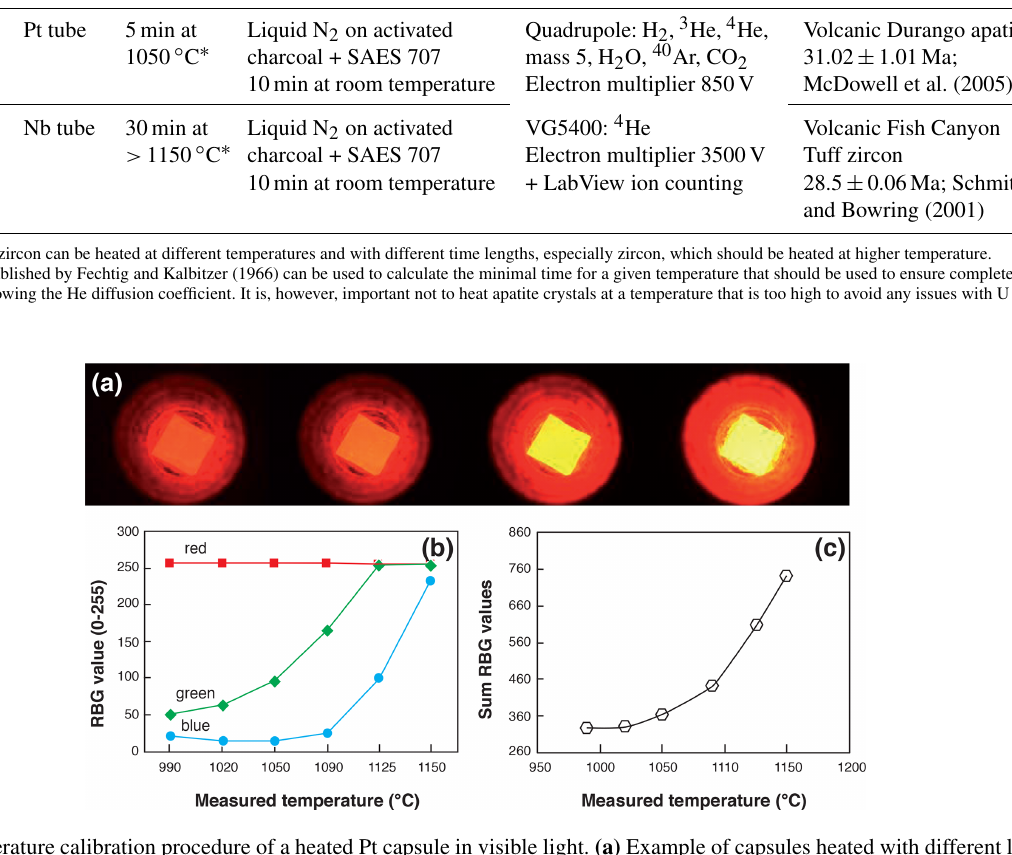
Table 1. Sample packing as well as He purification and analysis protocols. Minerals